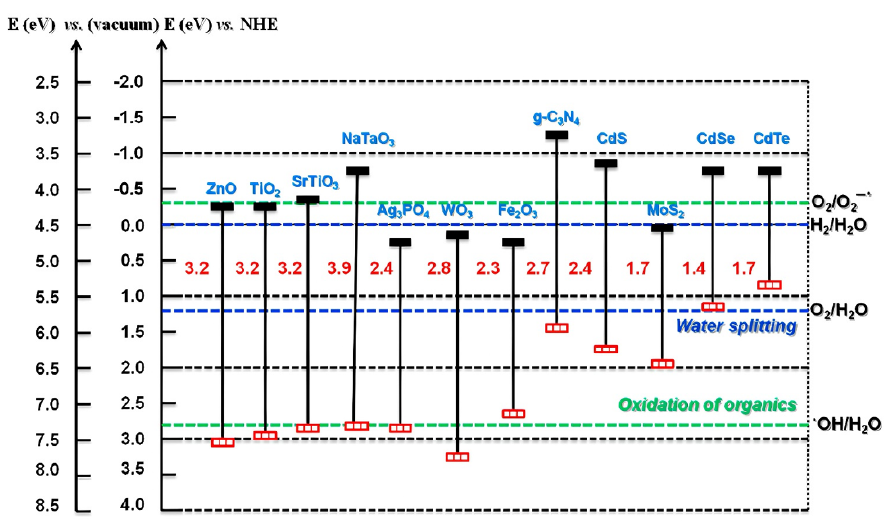
Figure 4. Band gap energy of various semiconductor photocatalysts. No special permission is re- quired to reuse all or part of article published by MDPI [159]. required to reuse all or part of article published by MDPI